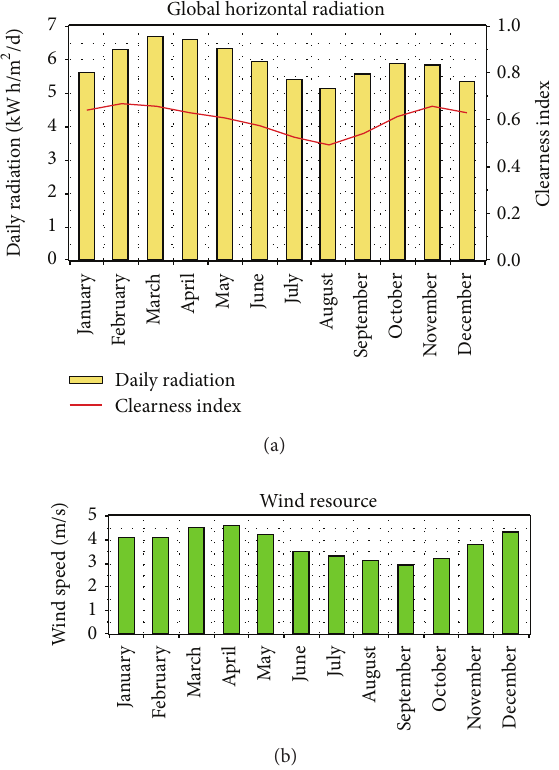
Figure 2: (a) HOMER output graphic for solar (clearness index and daily radiation) profile. (b) HOMER output graphic for wind speed